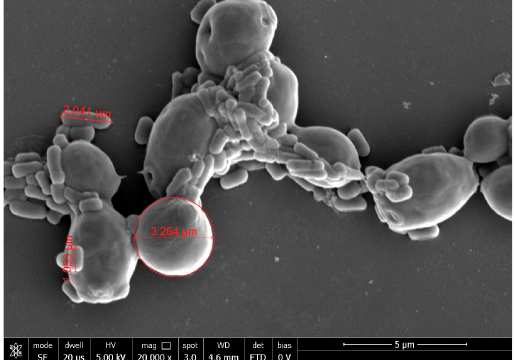
Figure 4. Representative image of SynBalance ® Femme mixture and C. albicans observed at SEM. Magnification 20,000 × .